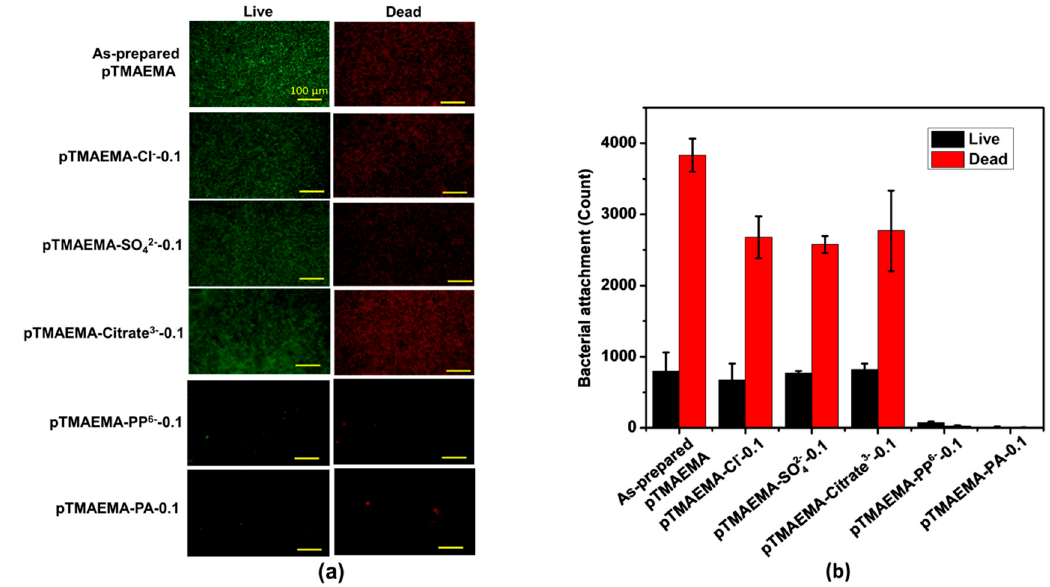
Figure 8. Bacterial fouling assessment. ( a ) Fluorescent images of bacteria attachment on pTMAEMA- anion-0.1. The bacteria used was E. coli . The color in green represents live bacteria, whereas that in red represents dead bacteria. Scale bar was 100 µm. ( b ) Quantification of E. coli attachment on different pTMAEMA hydrogel systems.